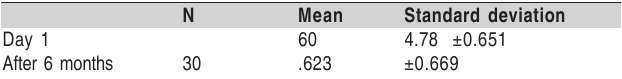
Table 3. Mean and standard deviation for masticatory efficiency of subjects on the day of denture fit and insertion and 6 months of denture usage